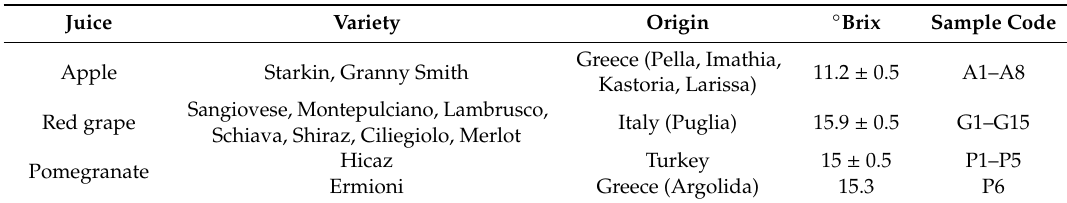
Table 1. Fruit juice